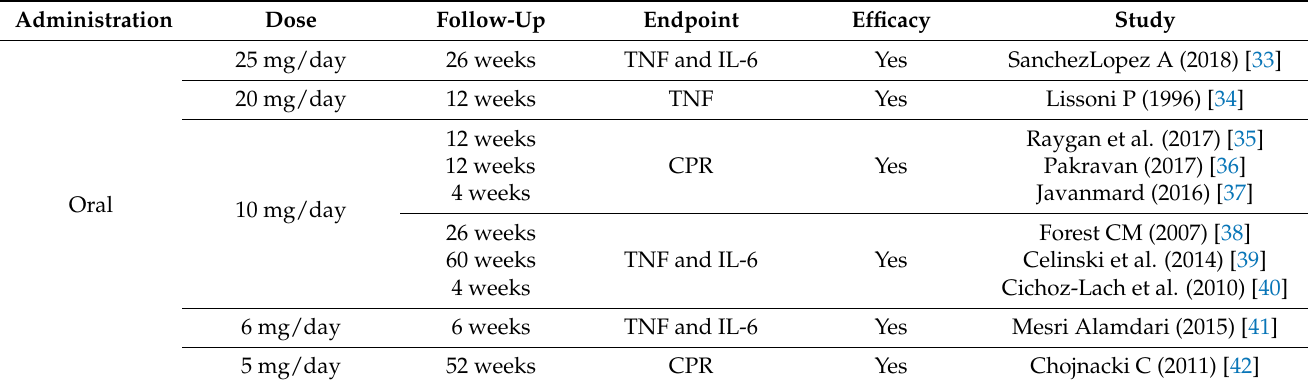
Table 6. Melatonin: summary of the principal characteristics of the included systematic reviews.